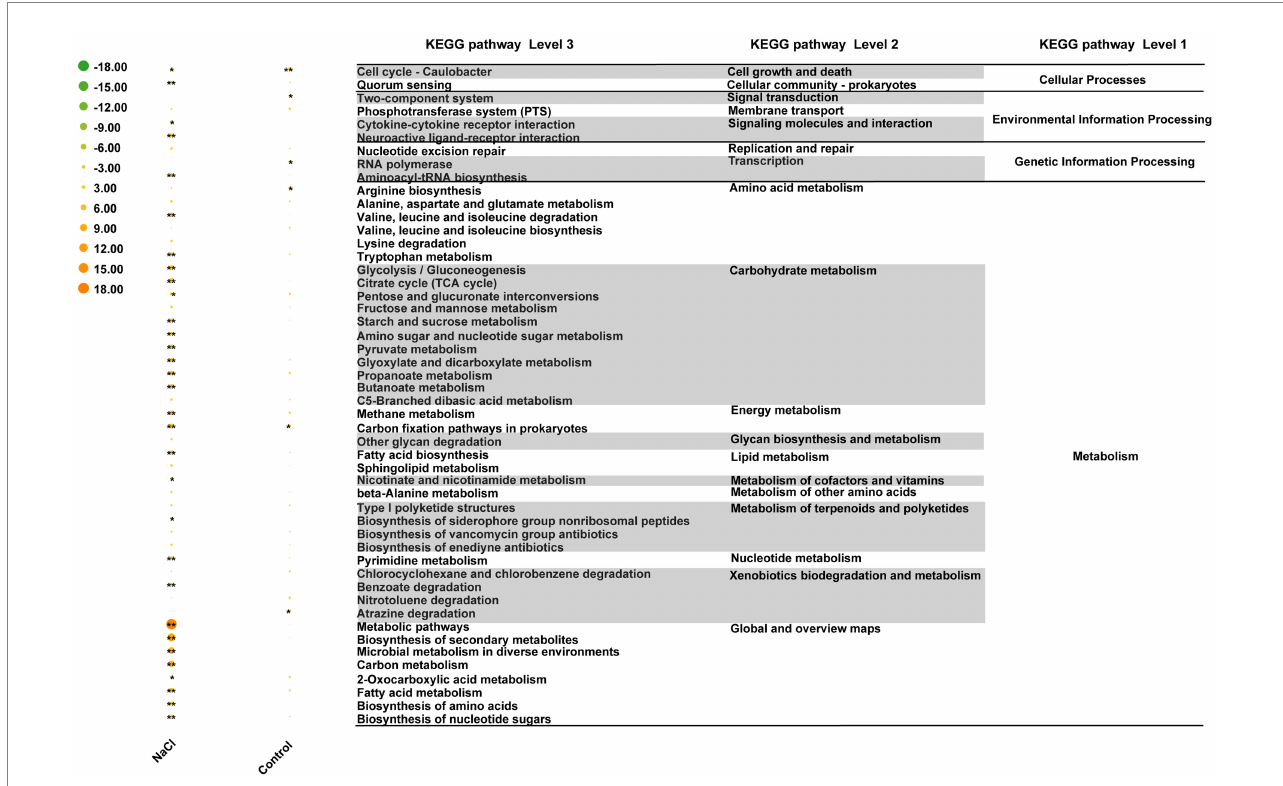
FIGURE 7 Heat map of top 50 KEGG pathways differentially enriched under salt stress in 101-14 and 5BB. Pathways are shown with a significant difference in reporter score. Green, enriched in rhizosphere microbiota of 101-14 treated with NaCl and ddH 2 O; orange, enriched in rhizosphere microbiota of 5BB in treated with NaCl and ddH 2 O. *denotes reporter score < − 1.96, or > 1.96. **represent reporter score < − 2.58, or >2.58. G1, 101-14 treated with NaCl; G2, 101-14 treated with ddH 2 O; G3, 5BB treated with NaCl; G4, 5BB treated with ddH 2